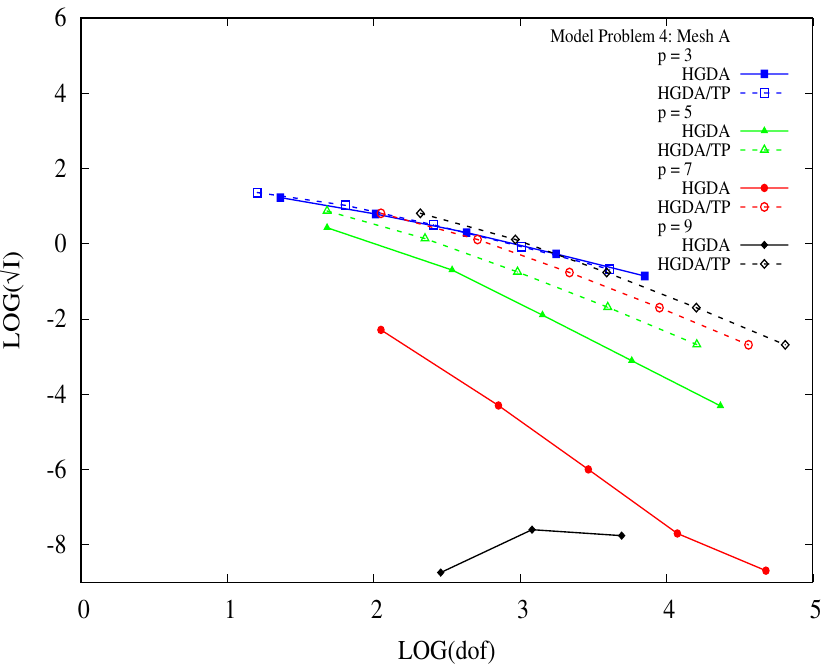
Figure 16. Residual function I versus dof, C 11 solutions: Model Problem 4 (Poisson’s Equation; Mesh A; HGDA/DG and HGDA/TP).